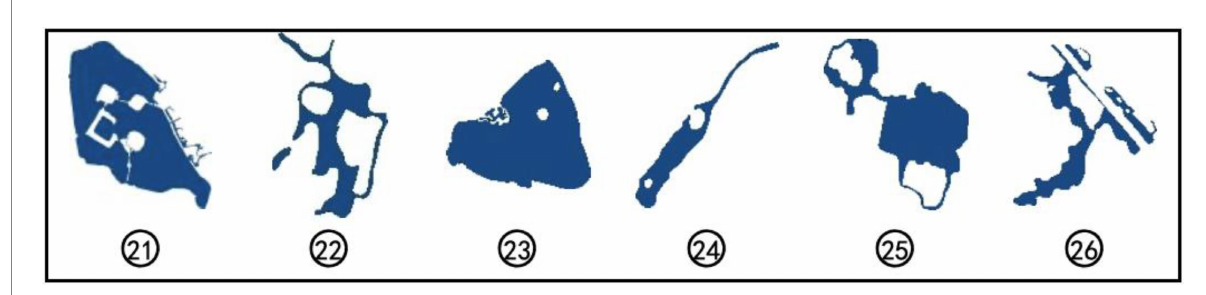
FIGURE 3 Historical and cultural water planar shape.